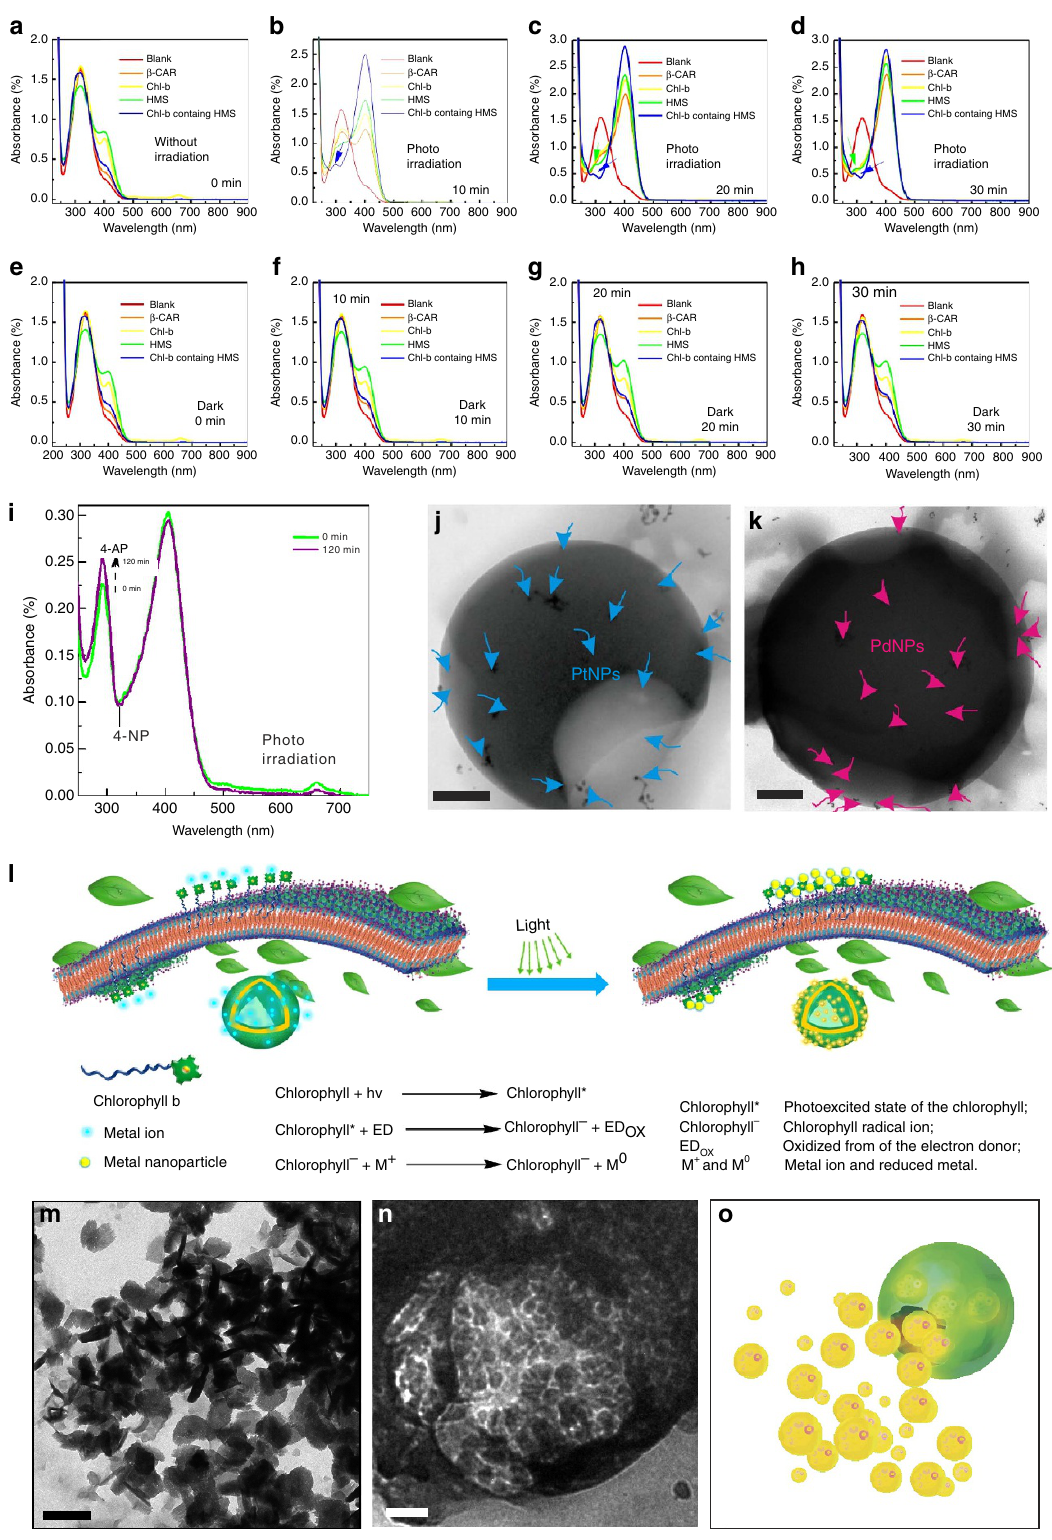
Figure 5 | HMS-based LHCs-b served as photocatalytic entities. Ultraviolet–visible spectra of the transformation of 4-NP into 4-AP under photocatalysis by b -CAR, Chl-b, HMS, and LHCs-b for ( a ) 0min, ( b ) 10min, ( c ) 20min and ( d ) 30min. ( e – h ) are the corresponding untreated control groups for ( a – d ). ( i ) Ultraviolet–visible spectra of the transformation of 4-NP into 4-AP under photocatalysis by LHCs-b. TEM images of j , a PtNPs-loaded LHCs-b (the blue arrows indicate the PtNPs); Scale bar, 100nm, and ( k ) a PdNPs-loaded LHCs-b (the pink arrows indicate the PdNPs); Scale bar, 200nm. ( l ) Possible photosynthesis mechanism of LHCs-b. ( m ) TEM micrograph of a self-broken HMS during the HCl-triggered degradation. Scale bar, 500nm. ( n ) TEM micrograph of an HMS containing AgNPs during the HCl-triggered degradation. Scale bar, 100nm. ( o ) Schematic showing the release of nanoparticles.